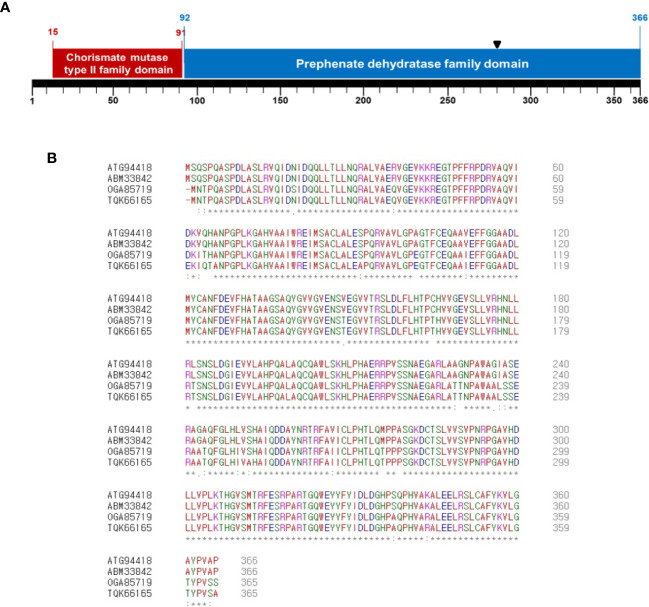
Sequence analysis of deduced amino acids of CmpAc. (A) Predicted domains in CmpAc. Red and blue boxes indicate chorismate mutase type II family and prephenate dehydratase family domains, respectively. A black arrow indicates the Tn5 insertional position. (B) Sequences alignment of CmpAc (ATG94418), prephenate dehydratase (ABM33842) from Ac strain AAC00-1, chorismate mutase (OGA85719) from Burkholderiales bacterium GWA2_64_37 (subsurface metagenome), and prephenate dehydratase (TQK66165) from Nocardioides sp. SLBN-35 using the Clustal Omega Program. The “*”, “:”, and “.” represent identical residues, conserved substitutions, and semi-conserved substitutions, respectively.